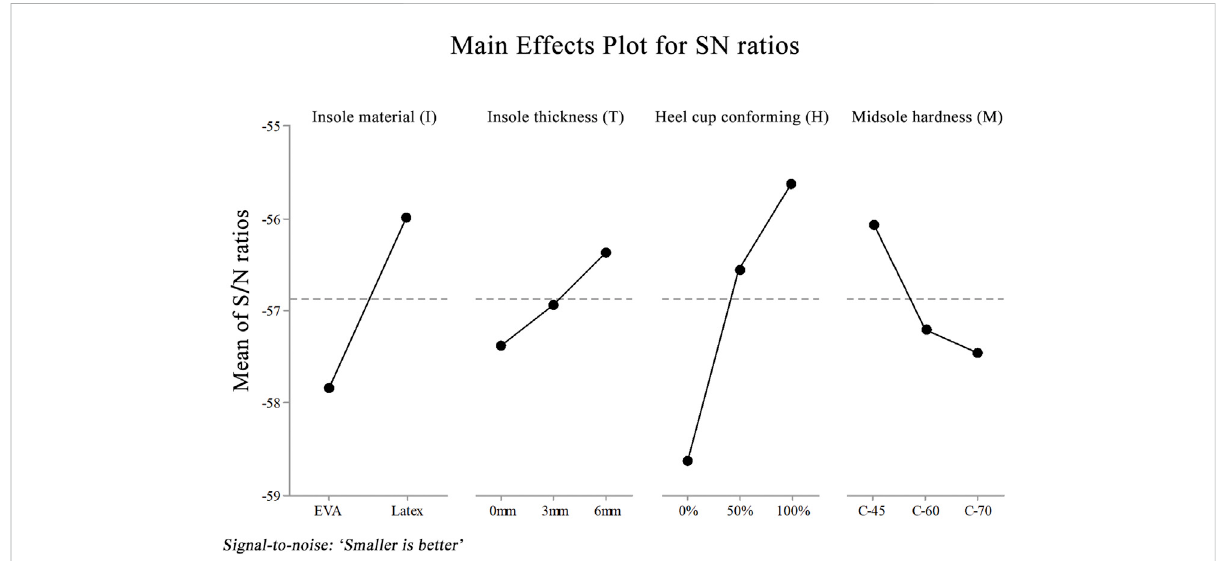
FIGURE 5 S/N graph for peak pressure. The X axis shows the different levels of each design factor. The Y axis shows the values of the S/N ratio.